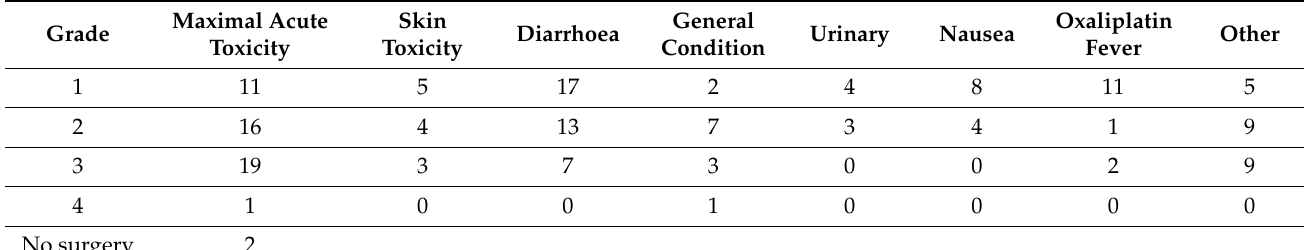
Table 2. Acute toxicity observed during preoperative therapy and first month after surgery in 47